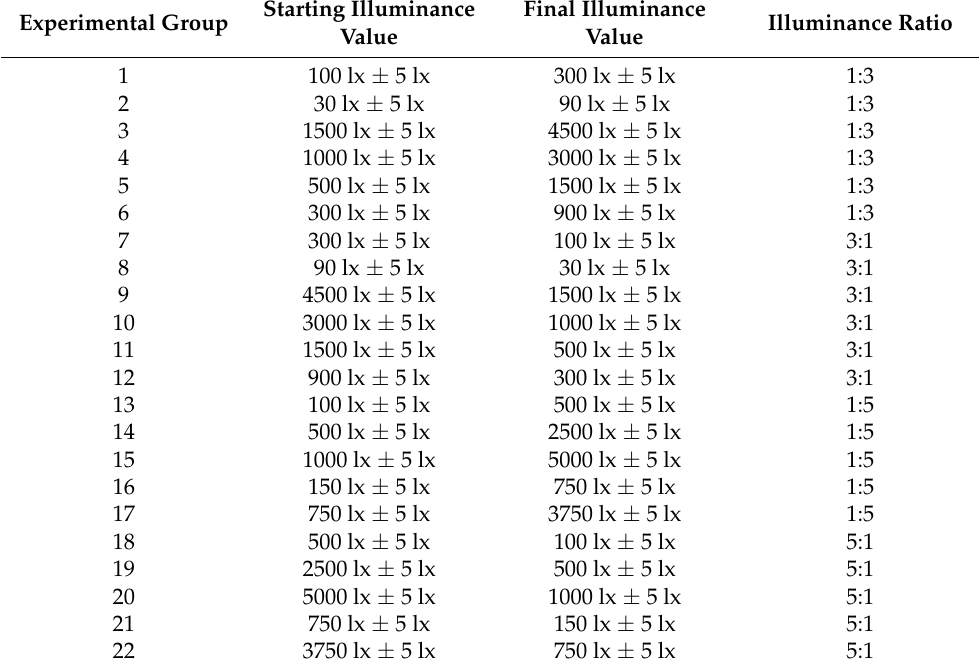
Table 2. Data of experimental group. Experimental